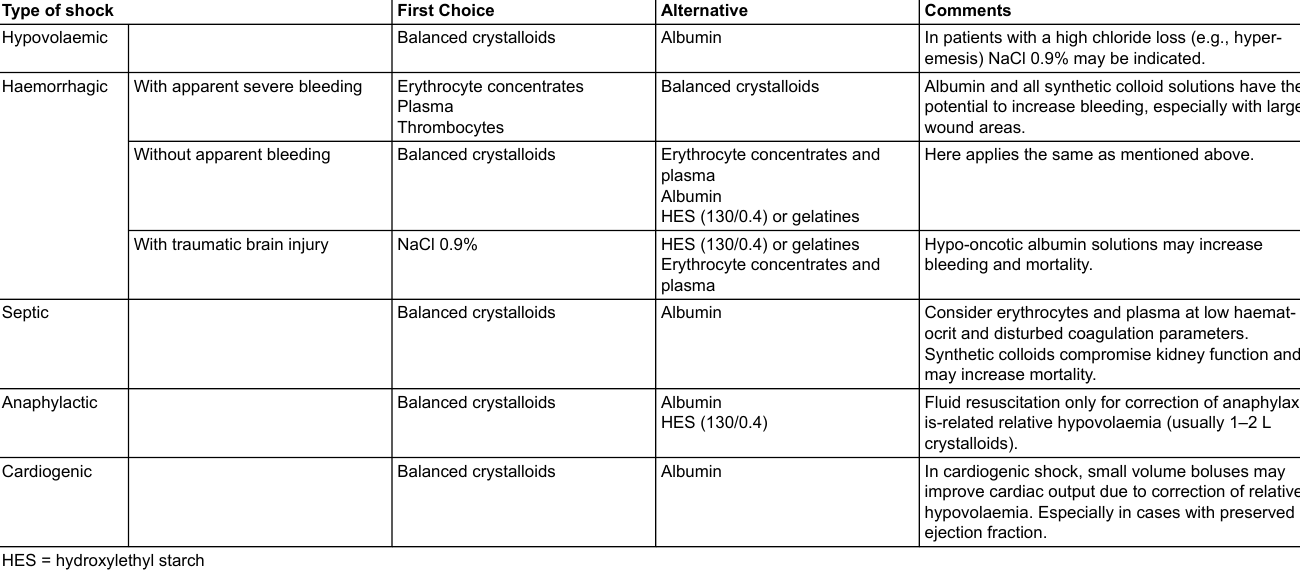
Table 2: Recommendations for the application of resuscitation fluids in different types of shock. Type of